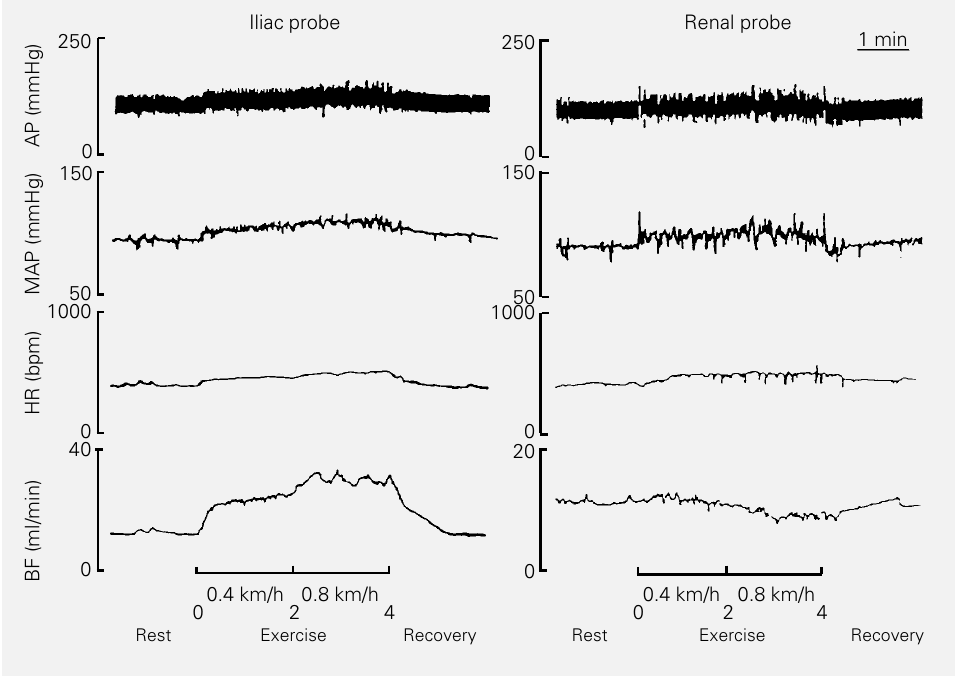
Figure 5 - Recordings of pulsa- tile (AP) and mean arterial pres- sure (MAP), heart rate (HR) and mean regional flow (BF) for 2 rats with a chronically implanted 1-mm probe (left panel, iliac flow and right panel, renal flow) during rest, exercise of mild (0.4